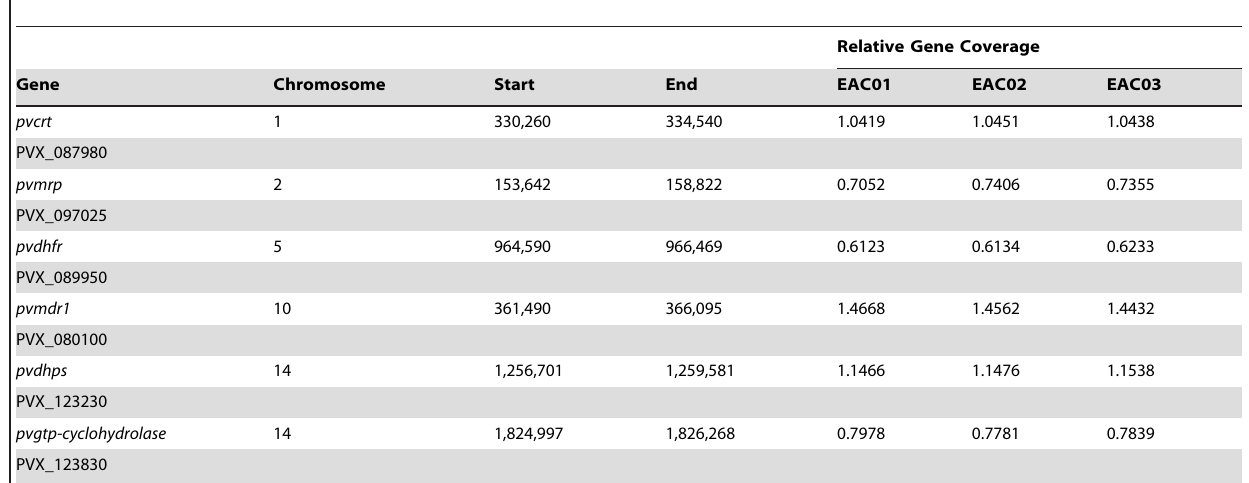
Table 5. Copy number variants in putative drug resistance genes from relapsing